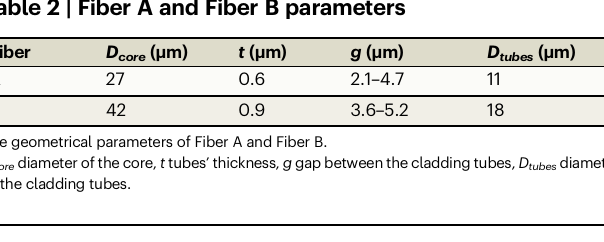
Table 2 | Fiber A and Fiber B parameters